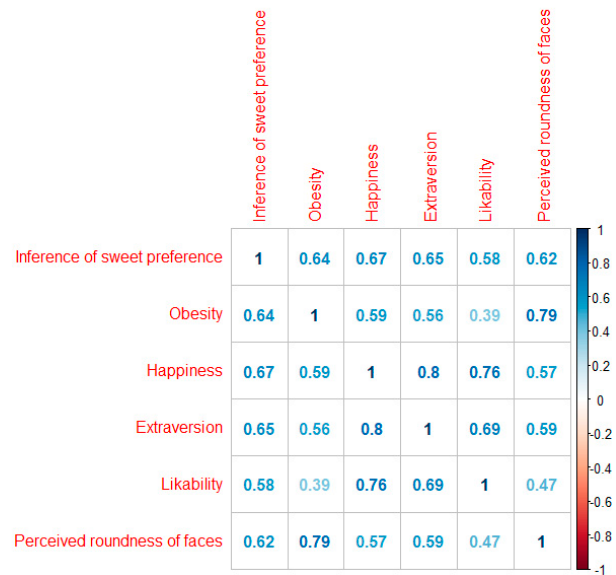
Figure A4. Scatterplot of the relationship between perceived extraversion and inferences of sweet preference.